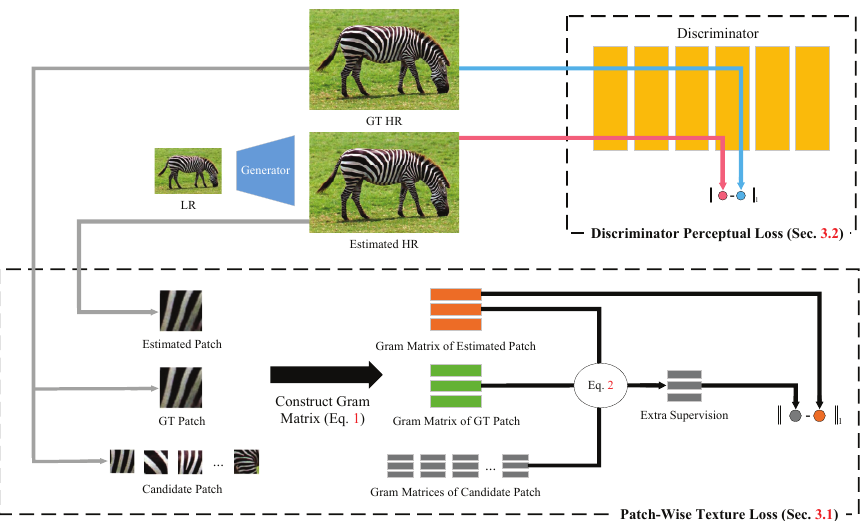
Figure 1. The whole framework of Gram-GAN. The discriminator perceptual loss is constructed by the output of the middle layer of the discriminator. The patch-wise texture loss gives texture-based supervision to the estimated